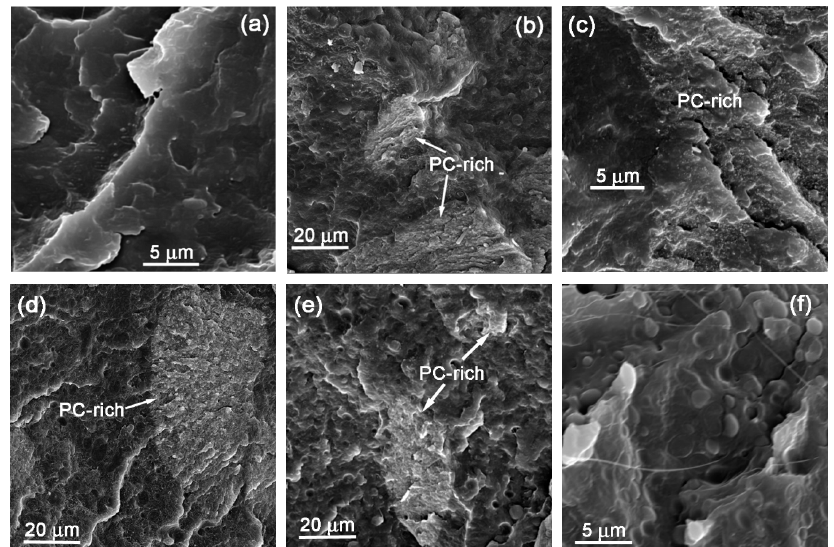
Figure 1. SEM images for ( a ) 30 / 70 / 0, ( b ) 28 / 65 / (6 / 1), ( c ) 22 / 51 / (23 / 4), ( d ) 51 / 22 / (23 / 4), ( e ) 65 / 28 / (6 / 1) and ( f ) 70 / 30 / 0 w / w PCL / PBS / (PC / MWCNTs) blend nanocomposites. Table 2. Particle sizes of the dispersed polymer phases in the PCL/PBS blends.